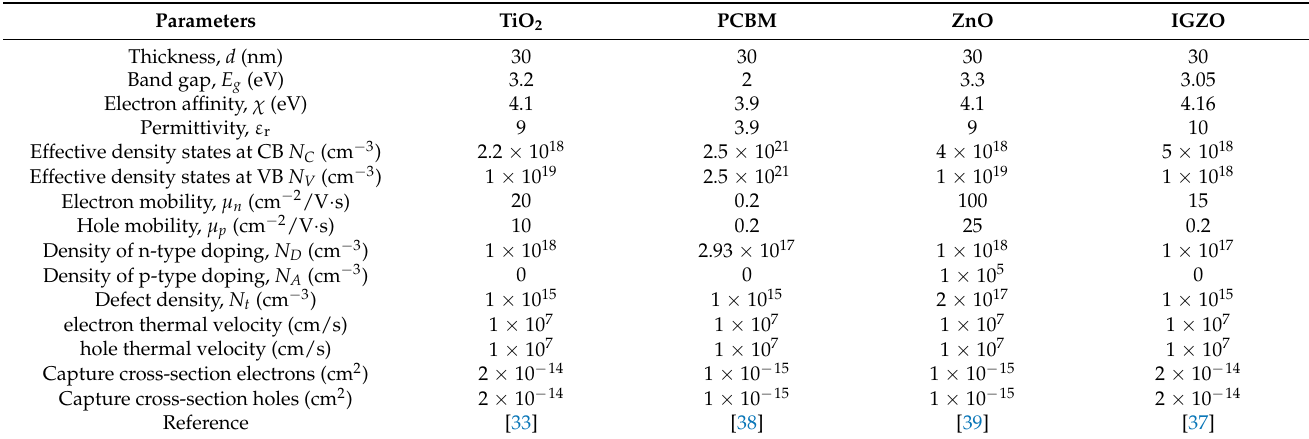
Table 3. Input parameters of defect inside the absorber and interface defect